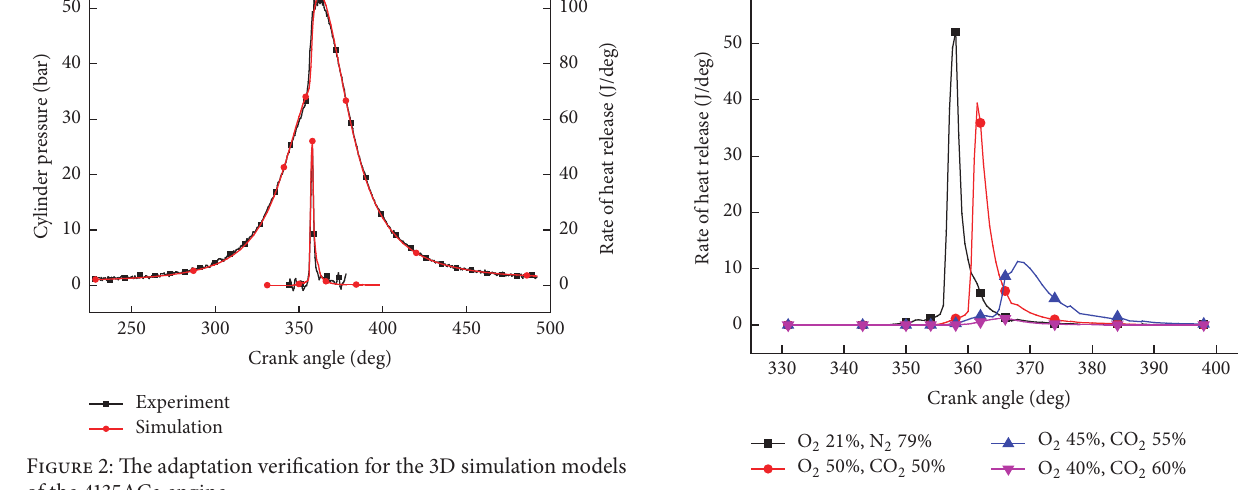
Figure 4: Curve of heat release rate under different O 2 volume fraction.